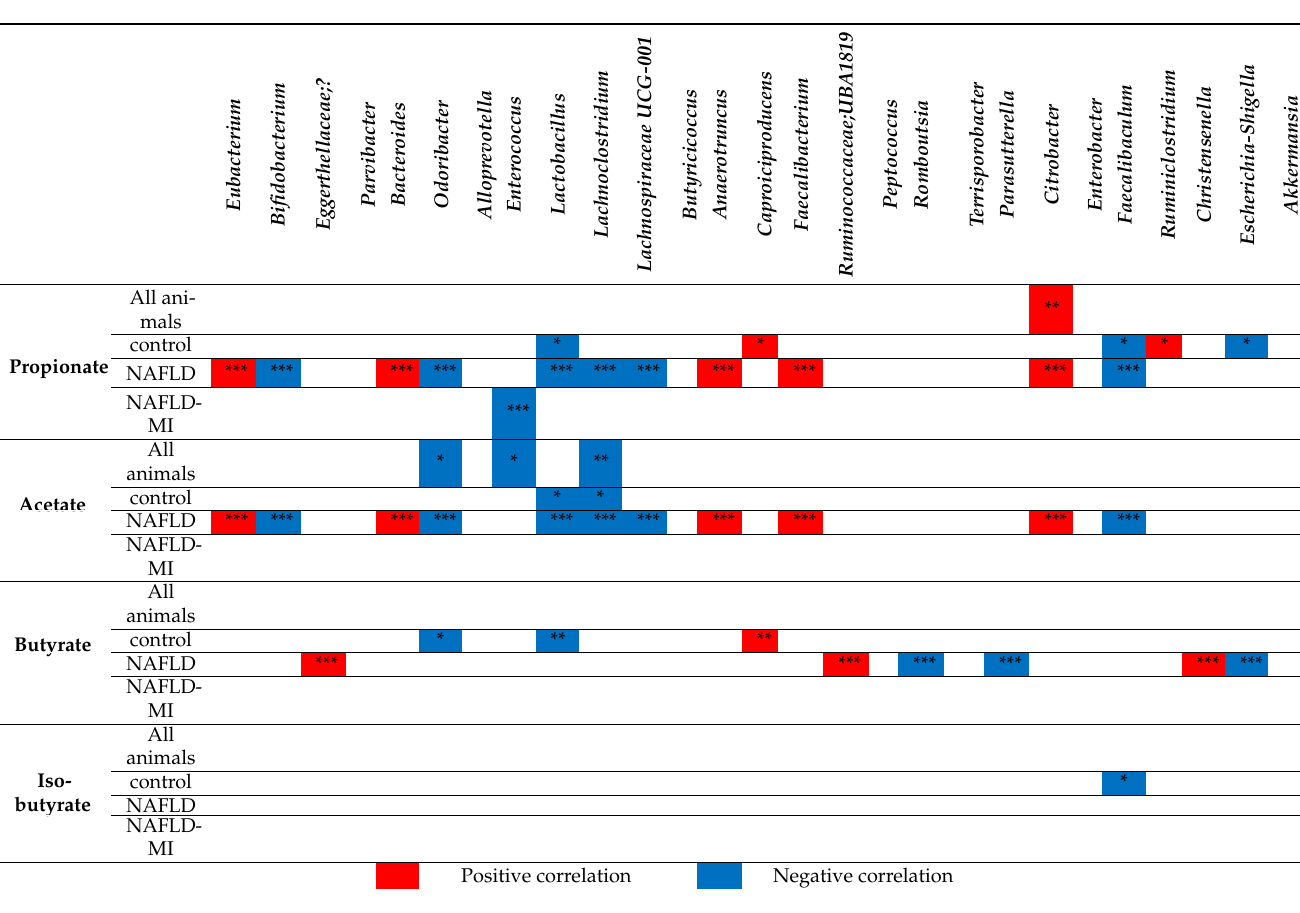
Table 2. Spearman correlation analysis of selected fecal genus bacteria and SCFAs in all animals, control, NAFLD, and NAFLD-MI groups. Boxes in red mean positive correlation and boxes in